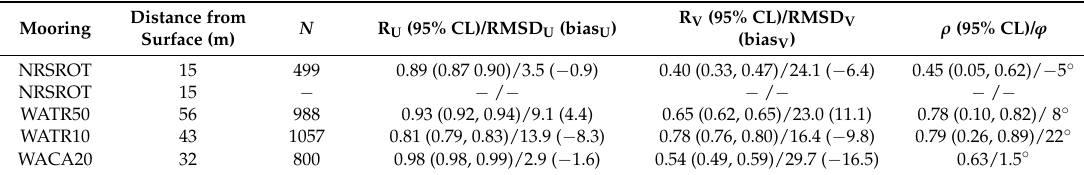
Table 5. Comparison between WERA HFR currents and SeaSonde − WERA HFR currents at the mooring locations. Units for RMSD and phase angle are cm/s and degrees, respectively. Positive (negative) values for phase angle indicate that WERA HFR currents are rotated counterclockwise (clockwise) from SeaSonde − WERA HFR